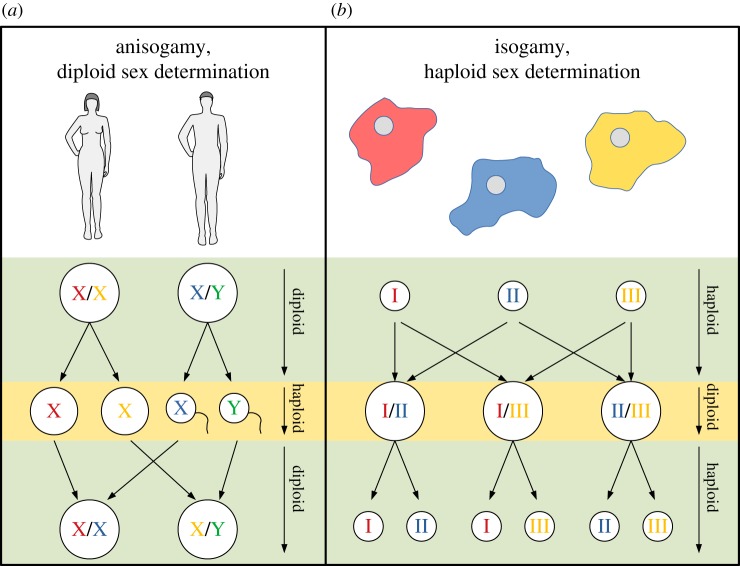
Comparison of the sexual life cycle of mammals when compared with a ‘typical’ isogamous species appropriate for our model. The life cycle of cells in mammals is dominated by a diploid state (green background). Here, the sex of the organism is determined by a pair of chromosomes (X/X in females and X/Y in males). The life cycle of cells in many isogamous species is dominated by a haploid state (green background). Here, an allele on a single chromosome determines the mating type (e.g. I, II and III in Dictyostelium discoideum). Mammals produce short-lived haploid sex cells (yellow background) that carry one chromosome type of the diploid parent. Their morphology differs according to the sex of their parent. A large egg cell and small sperm cell merge and form a diploid zygote which develops to the progeny. Cells of isogamous species, on the other hand, are equally sized and can reproduce asexually and sexually. During the sexual phase, two cells of different mating types merge to form a diploid zygote. From this short-lived diploid state (yellow background), the progeny emerge as haploid cells inheriting the parental mating types with equal probability.